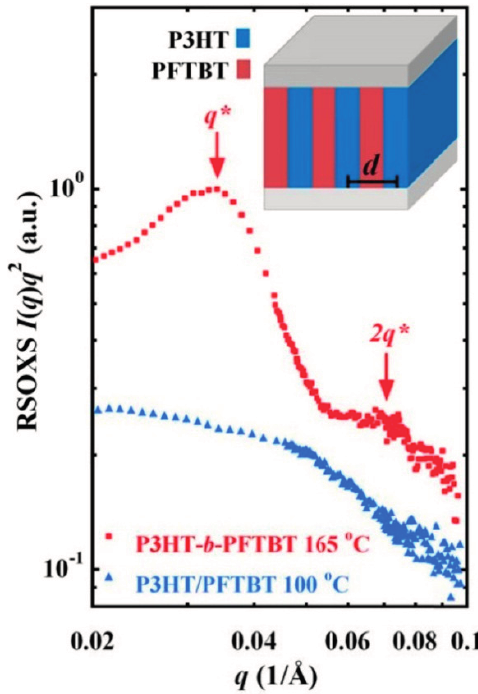
Figure 9. Resonant soft X-ray scattering data showing a well-defined primary scattering peak, q * , and a weak second-order peak, 2q * , indicating the presence of lamellar domains in donor–acceptor block copolymer P3HT- b -PFTBT, with a period of d = 18 nm. Reproduced from [125] with permission from The American Chemical